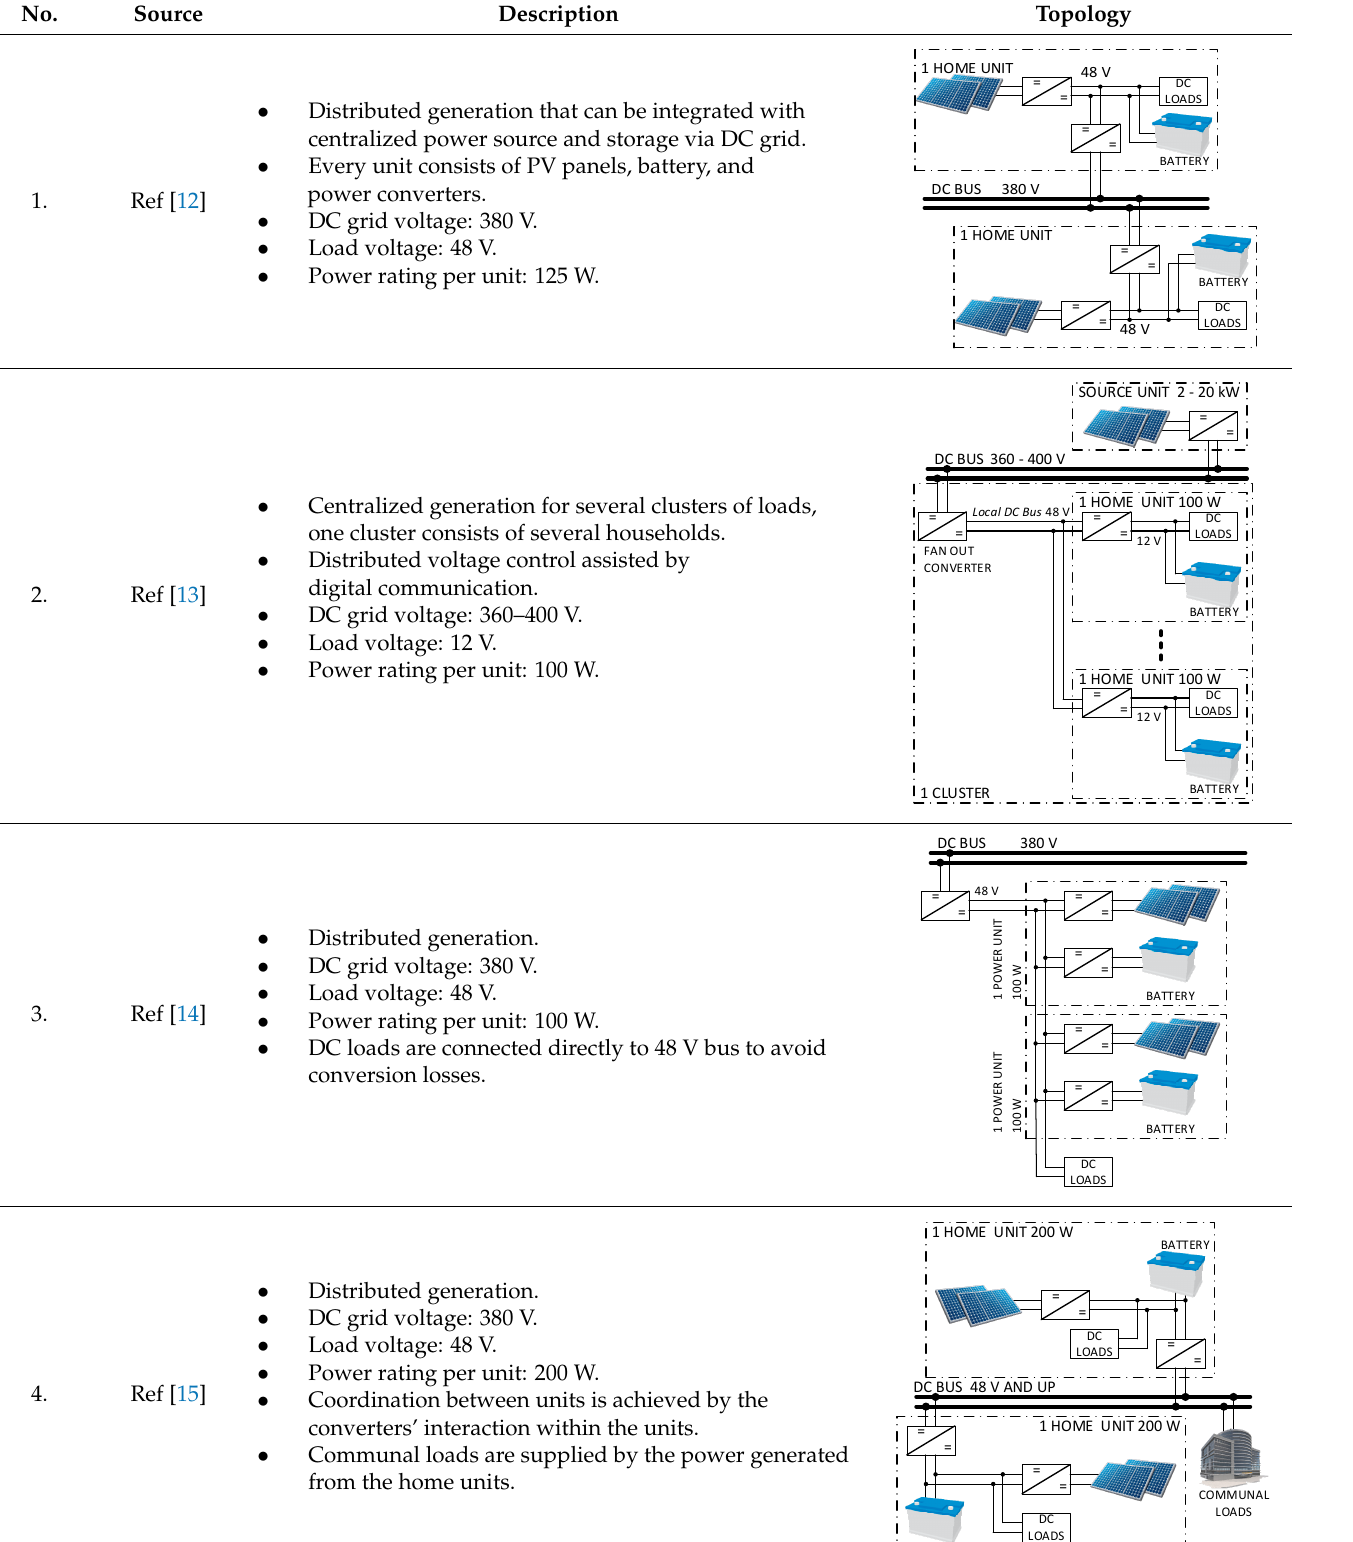
Table 3. Comparison of several DC microgrid systems.